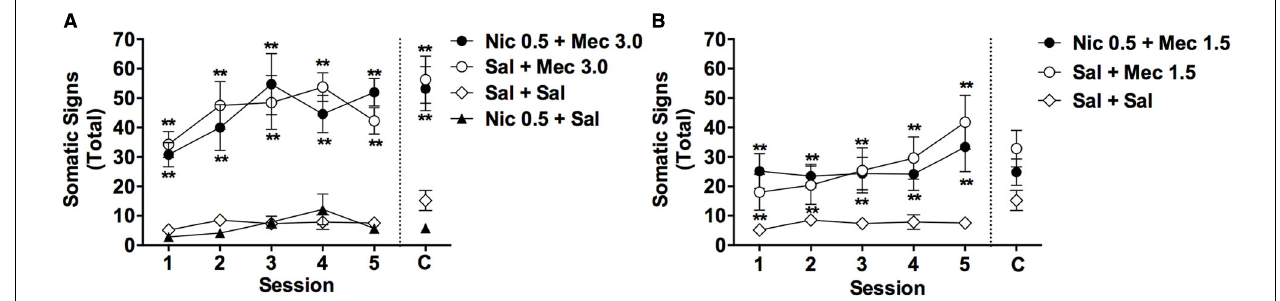
FIGURE 1 | Effects of acute mecamylamine, nicotine, and their combination on somatic signs in adolescents. Mean ( (cid:6) SEM) total number of somatic signs during each test session in Experiment 1. For clarity, data from the Nic + Mec 1.5 and Sal + Mec 1.5 groups are graphed separately in (B) . Data from the Sal + Sal group are included in both (A) and (B) . C = Challenge test conducted 1 week after session 5. **Significantly different from Sal + Sal group, p <